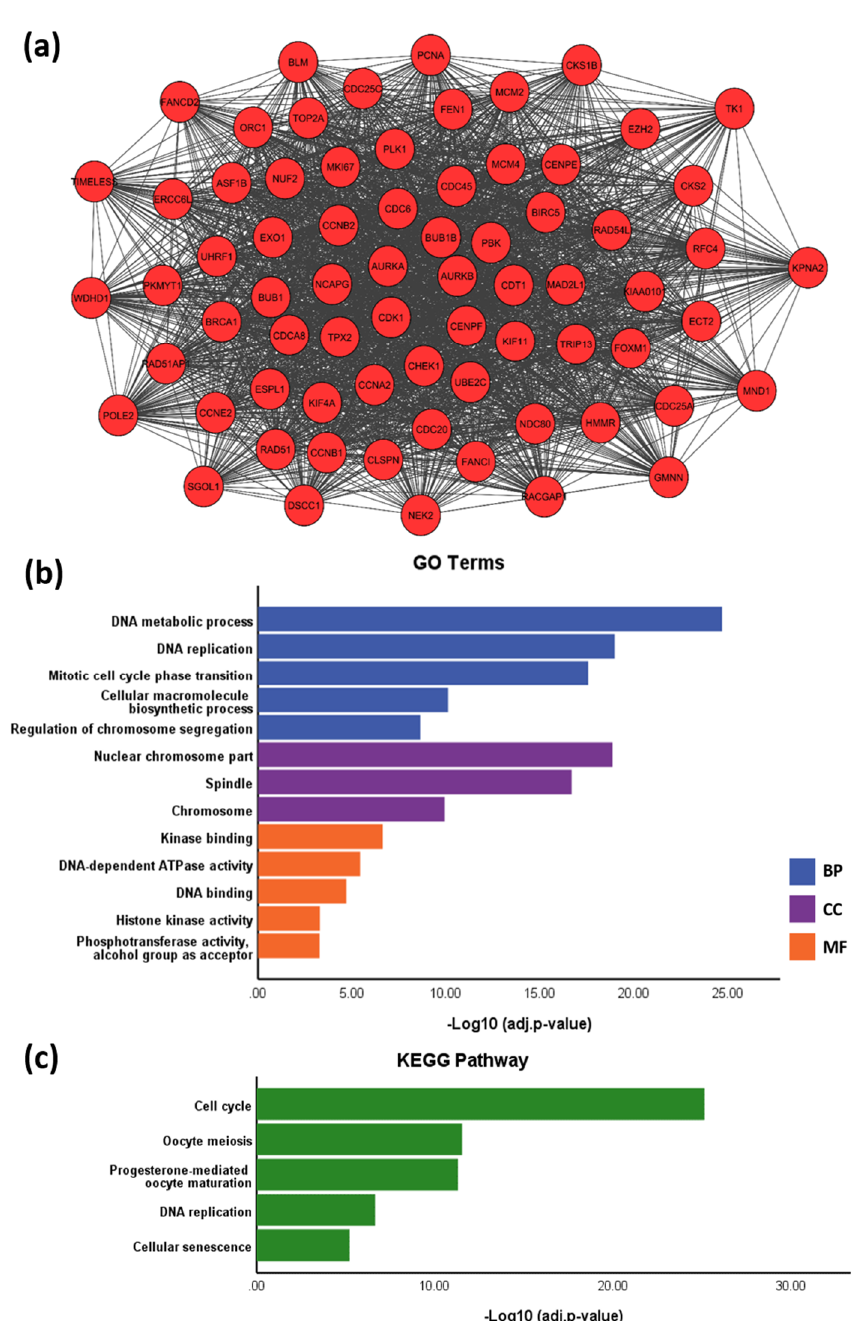
Figure 8. ( a ) The module identified in the PPI network of DEGs using Molecular Complex Detection (MCODE). MCODE score = 64.171. Degree cut-off ≥ 2. ( b ) GO terms and ( c ) KEGG pathways